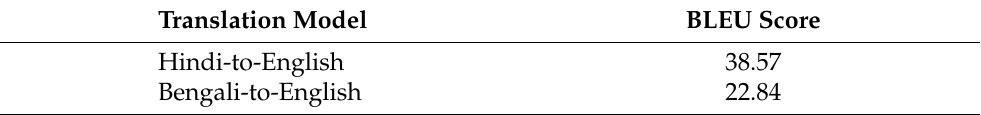
Table 3. BLEU scores for Indian-to-English language translation models on the Samanantar dataset. Translation